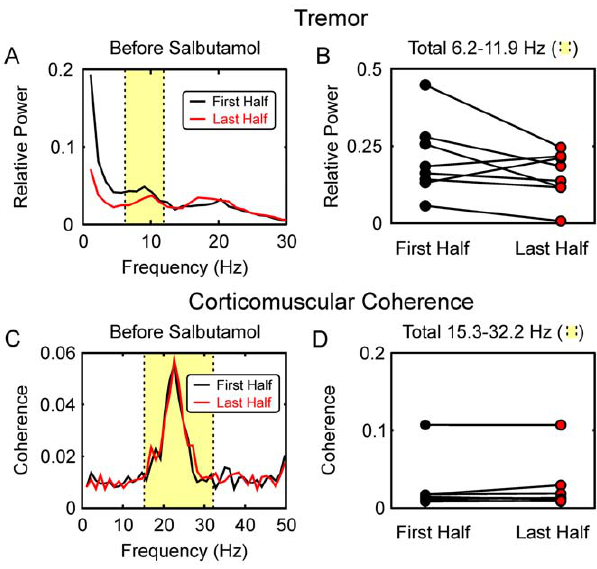
Figure 6. Reproducibility of Tremor and Corticomuscular Coherence. A, finger acceleration power spectra, measured prior to salbutamol administration, averaged across all eight subjects. The available recording from each subject was divided in half, and each half analysed separately. B, total acceleration power over the 6.2–11.9 Hz range (yellow shading in A) in each half of the recording. Each point shows data from one subject; lines link data from the same subject. Data points are colour coded to match the colours used in (A). C, corticomuscular coherence, averaged over all five muscles and eight subjects, measured from the first and last half of the available recording in each subject during performance of the auxotonic precision grip task. D, single subject data for the average coherence in the 15.3–32.2 Hz band (yellow shading in C), using the same format at (B). There was no significant change in either tremor or coherence between the first and last half of the recorded datasets (P . 0.05).